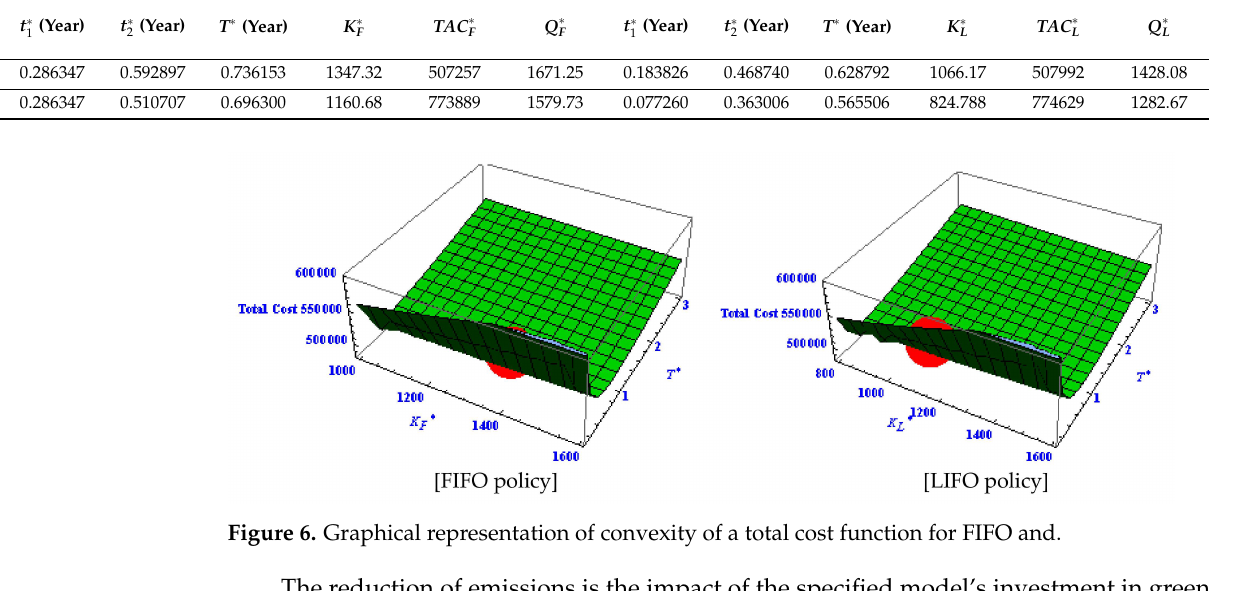
(cid:16) (cid:17) 1 − e − bG and the